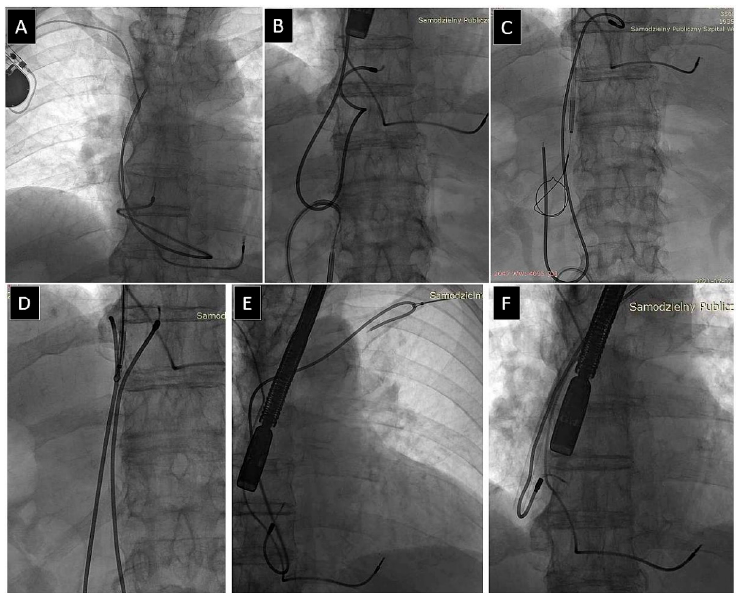
Figure 6. Use of alternative venous approach. A lead with its proximal end outside the generator pocket ( A ). If it is not retrievable with the lasso catheter via the superior approach, it has to be pulled down to free the end ( B , C ). The free end can be grasped again via the superior approach ( D ). The manoeuvre allows the operator to continue the procedure using conventional techniques ( E , F ) [32,41].